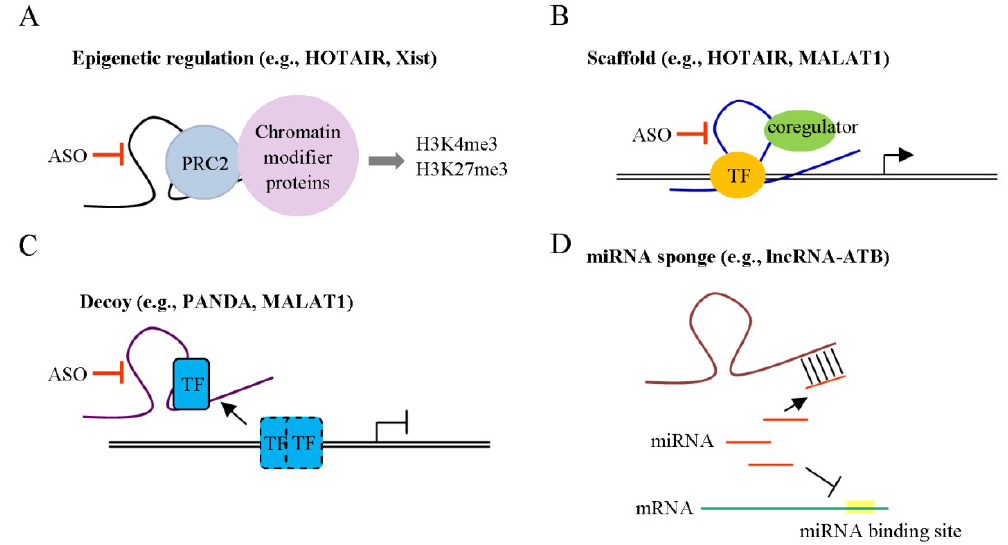
Figure 1. Different mechanisms of action of long non-coding RNAs (lncRNAs). lncRNAs mediate functions by regulating gene expression via diverse molecular mechanisms. ( A ) lncRNAs associate with chromatin-modifying complexes to modulate epigenetic modifications. ( B ) lncRNAs interact with transcriptional factors (TF) or coregulators to regulate gene expression. ( C ) lncRNAs sequester TFs away from chromatin to regulate gene expression. ( D ) lncRNAs serve as a sponge and interact with miRNAs to suppress miRNA–mediated effects. Antisense oligonucleotides (ASO) target